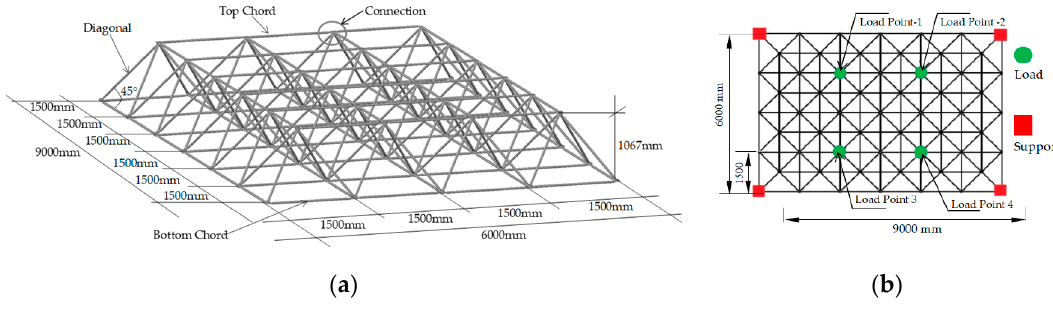
Figure 16. Space trusses tested: ( a ) Dimensions and ( b ) plan view of the prototypes. 23 of 23 Materials 2020 , 13 , x FOR PEER REVIEW